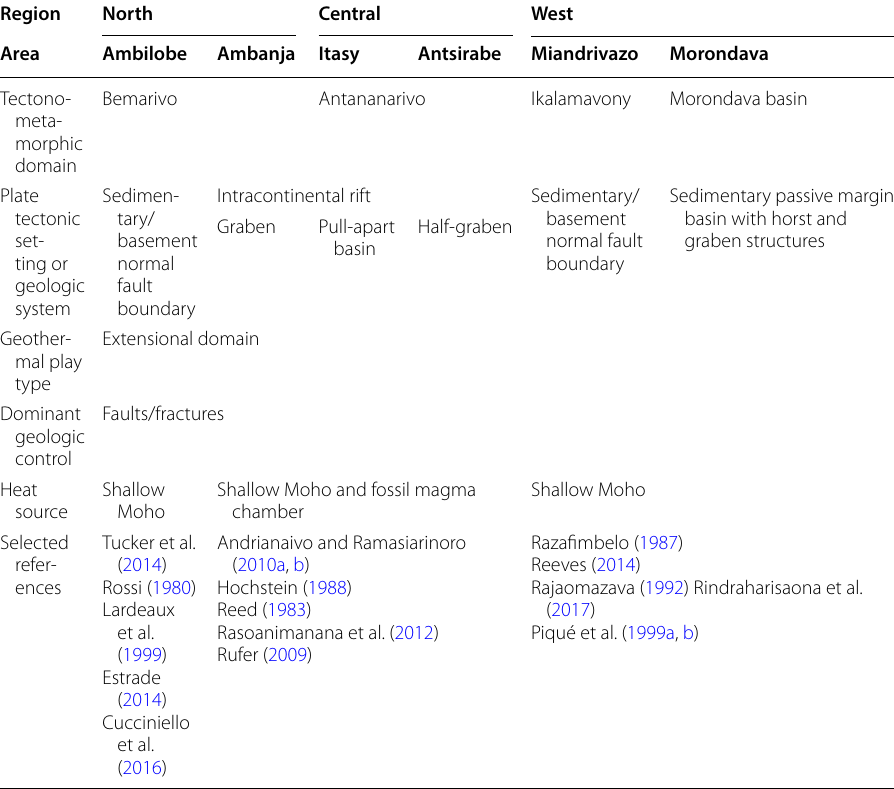
Table 2 Geological and tectonic controls for prospective areas in Madagascar Region